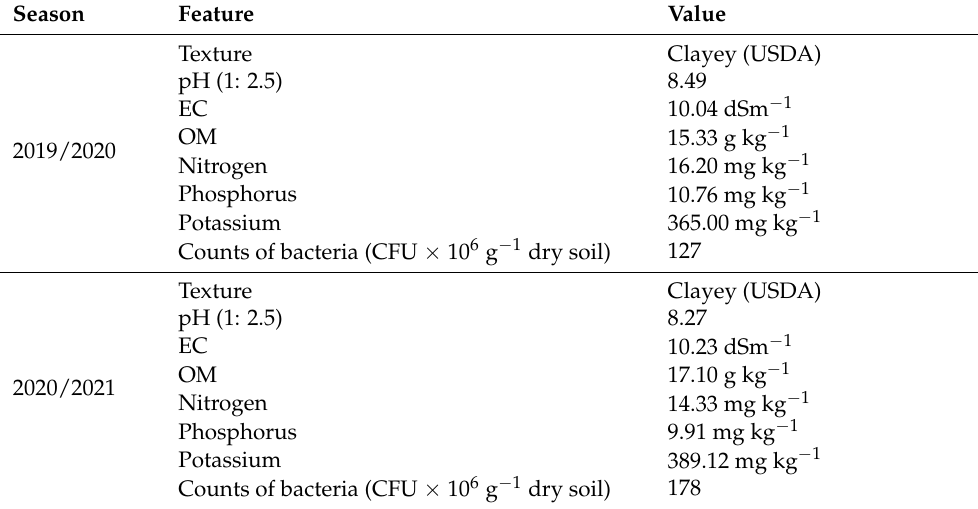
Table 1. Some physicochemical and biological properties of soil used in the two winter growing